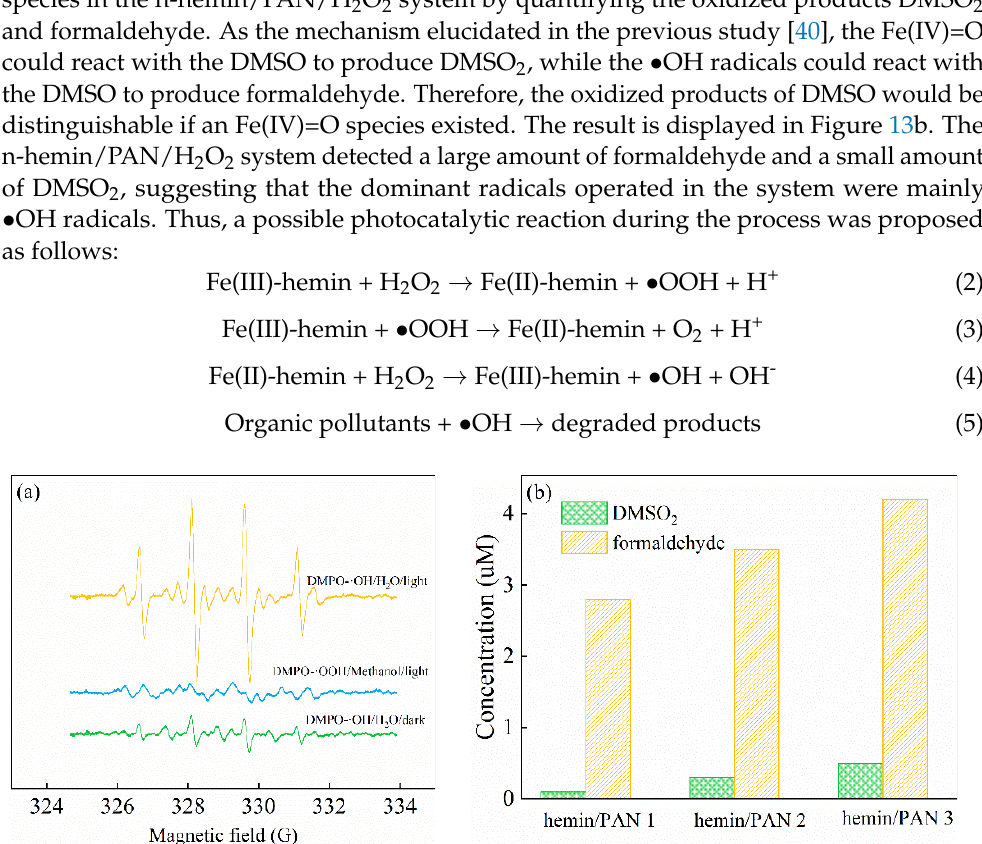
Figure 13. The ESR signals of DMPO- • OH and DMPO- • OOH adducts during the catalytic system ( a ), and DMSO 2 and formaldehyde concentration ( b ) in the system of n-hemin/PAN/H 2 O 2 .